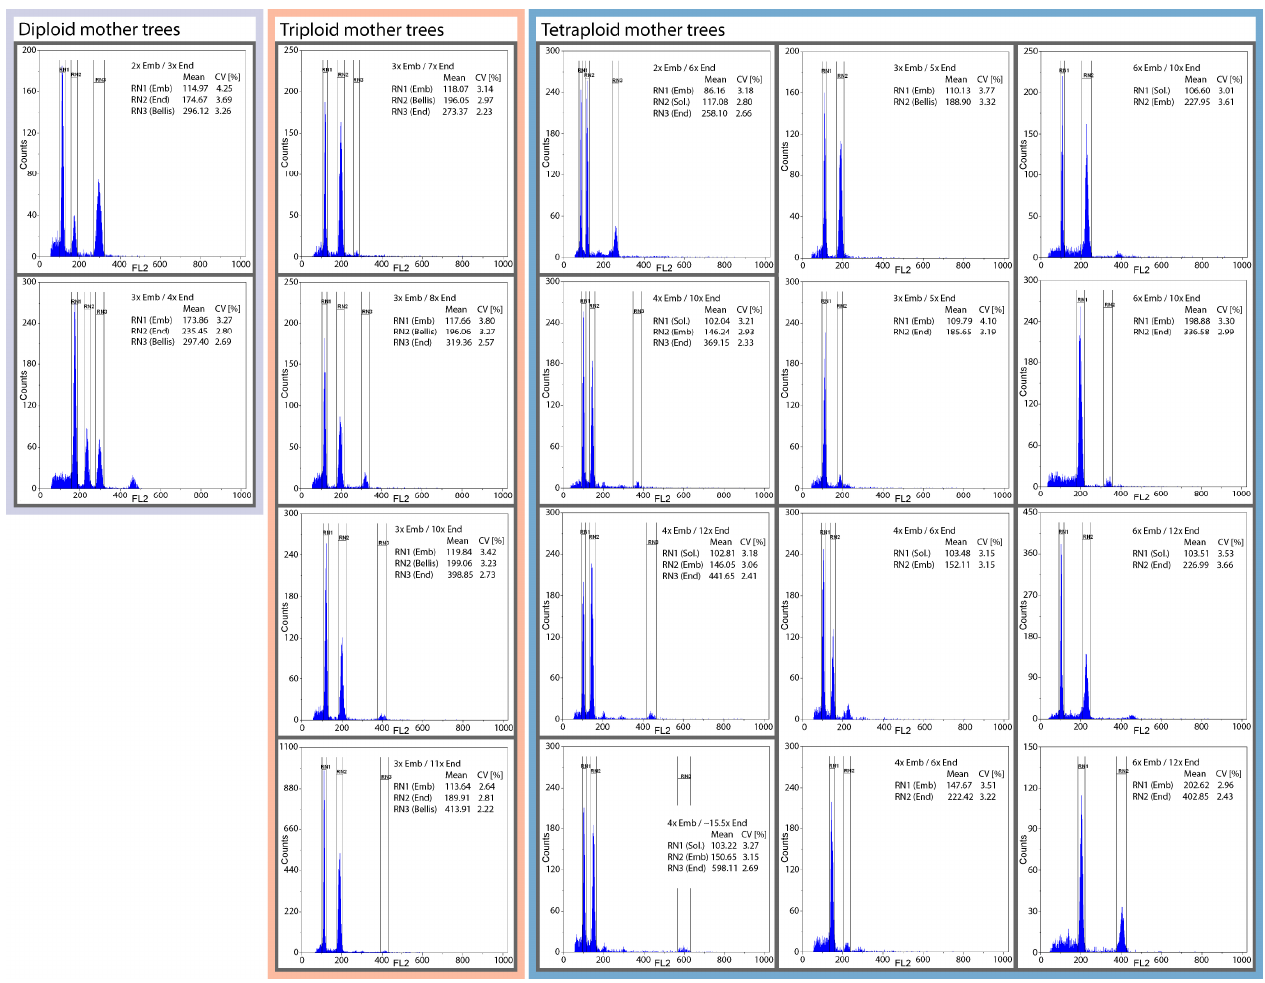
Figure 4. Examples of flow cytometric seed screen (FCSS) histograms and relative fluorescence ( FL2 ) vs. counts of nuclei ( Counts ) for most frequent seed types in diploids, triploids, and tetraploids. Each analyzed seed is outlined in dark grey. Two separate measurements, embryo + reference standard and embryo + endosperm, were necessary to clarify the reproduction mode of some seeds. Mean value of fluorescence intensity of nuclei ( Mean ) delimited in peaks ( RN1 – RN3 ) and corresponding coefficient of variation ( CV ) are reported. Emb –embryo, End –endosperm, Bellis –reference standard Bellis perennis , Sol. –reference standard Solanum lycopersicum